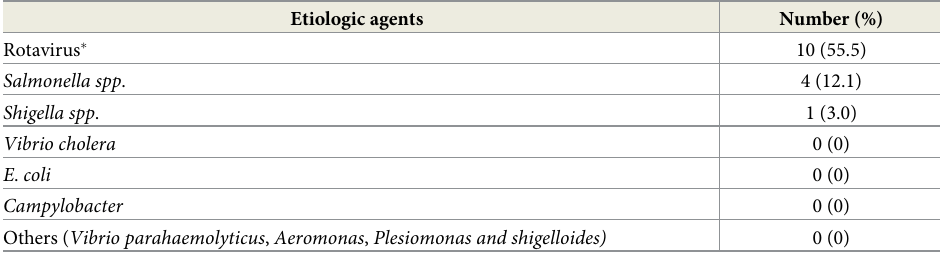
Table 2. Distribution of identified enteric pathogens in U5 children with acute diarrhea.